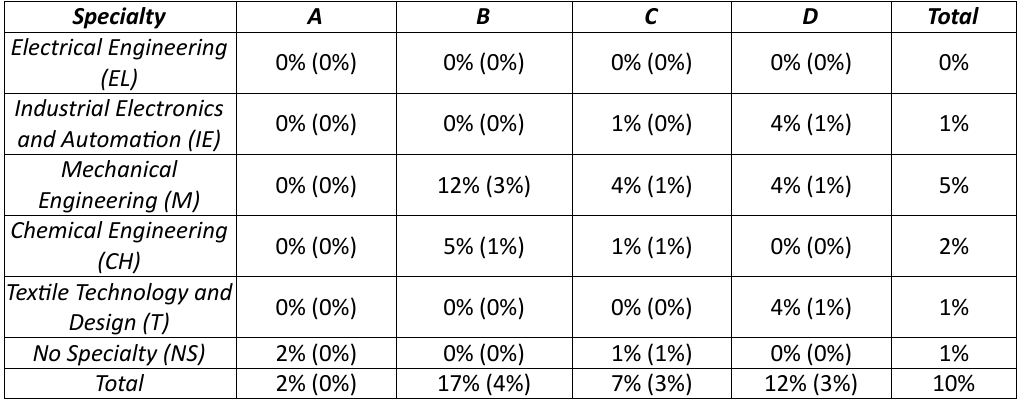
Table 7. Academic year 2013/14 - Percentages of grades equal to or beter than 8/10, by group and specialty (the percentage of the total is indicated in parentheses)